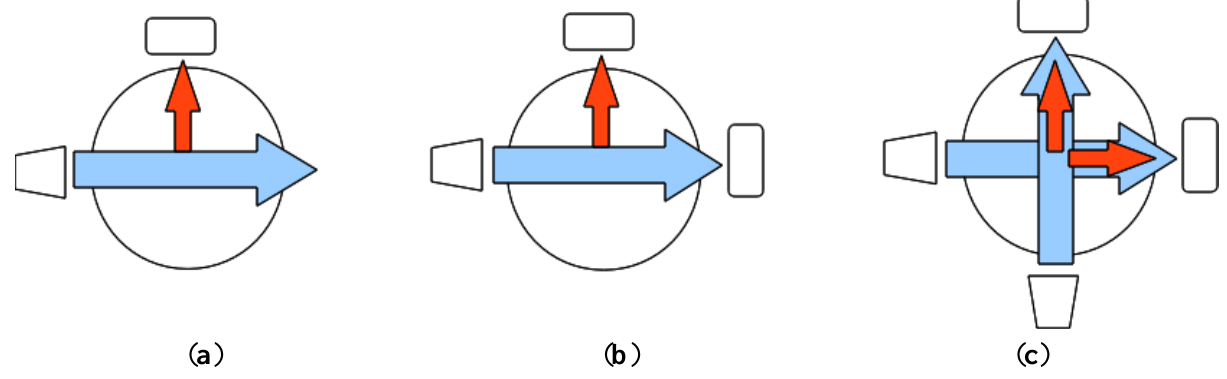
Figure 1. Common turbidimeter design patterns: ( a ) single-beam, ( b ) ratio, ( c ) modulated four-beam. Components: light source (trapezoid), liquid sample (circle), detector (rectangle), transmitted light (large arrow), scattered light (small